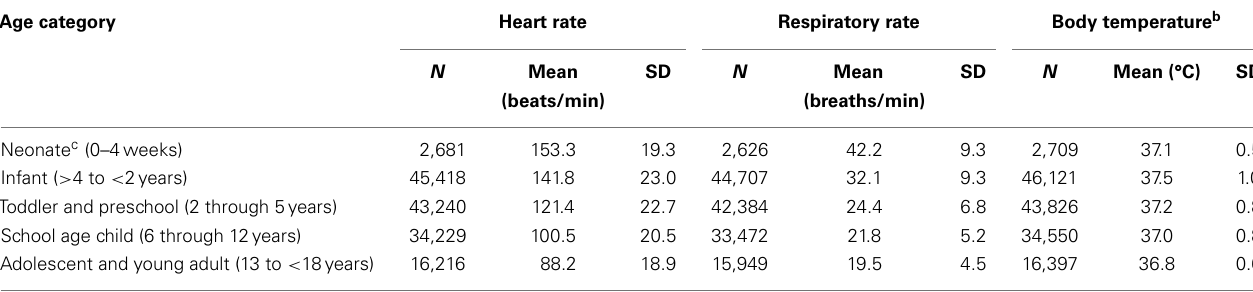
Table 2 | Characteristics of pediatric vital signs standardization group ( N = 143,603) a .